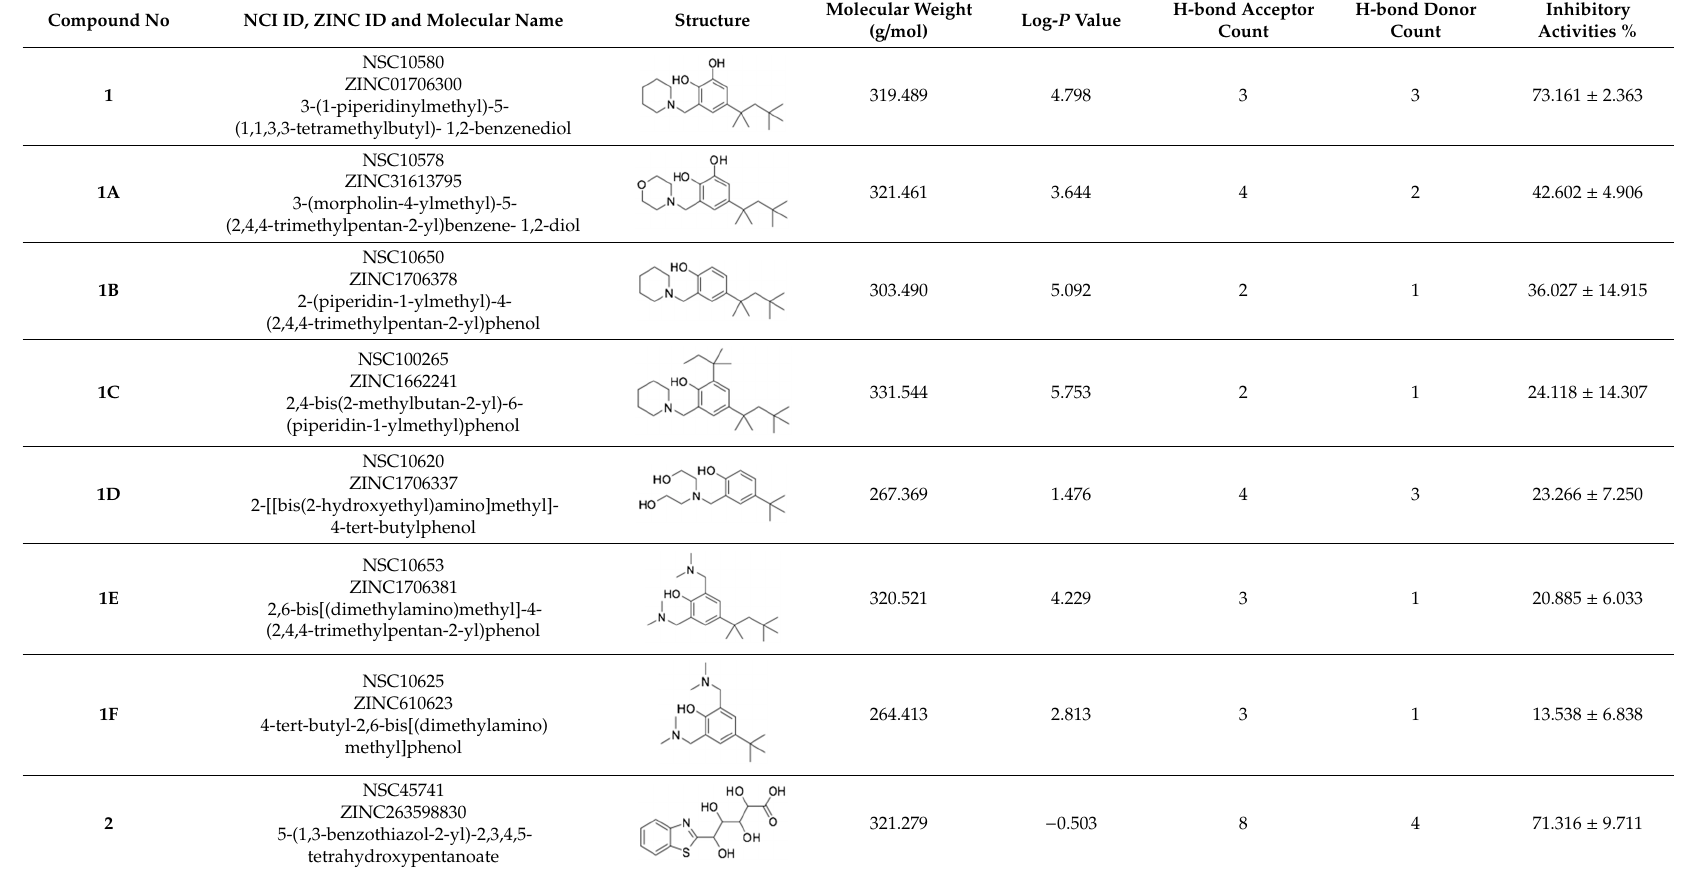
Table 1. Initial compounds identified by structure-based virtual screening and antiviral evaluation. Compounds presented by National Cancer Institute (NCI) ID, ZINC ID, molecular name, 2D chemical structure, chemical properties, and experimental inhibitory activities. Inhibitory activities at 20 μ M were evaluated by in vitro ZIKV infection assay.